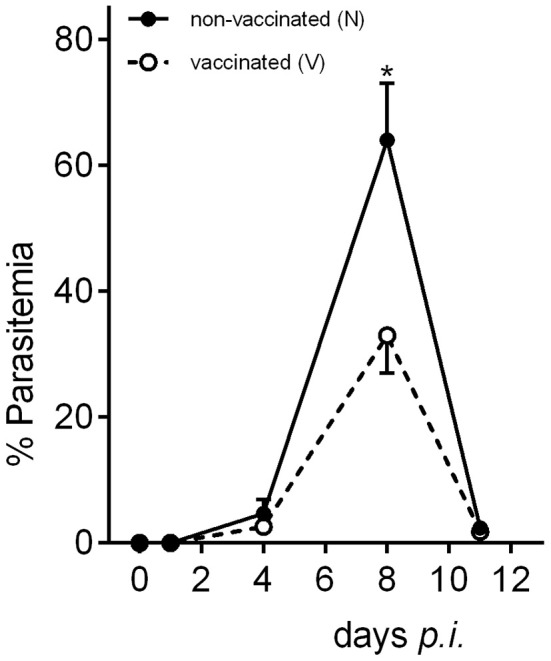
Course of parasitemia during self-healing infections of P. chabaudi in vaccination-protected Balb/c mice and lethal infections in non-vaccinated mice. Values represent means determined from three mice whose livers were taken to analyze miRNA expression. Bars represent half SD and star indicates significant difference (p < 0.01).